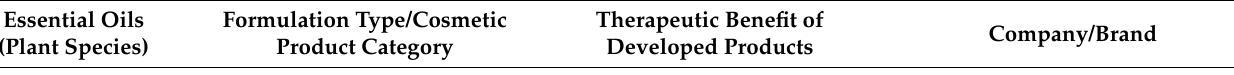
Table 2. South African cosmeceutical products developed from essential oils of African/global origin, product benefits, and companies/brands involved in the